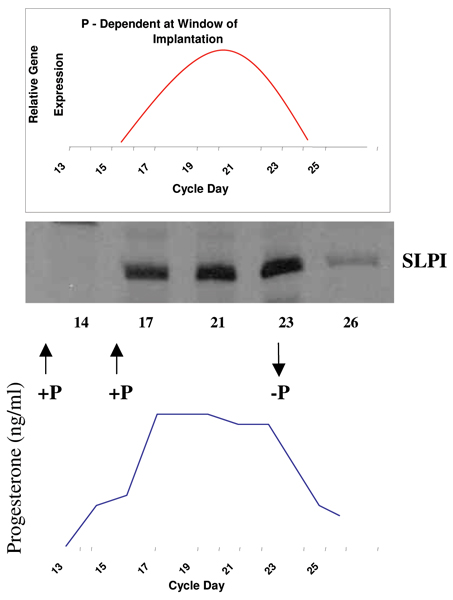
SLPI expression and hormonal levels of progesterone (P) during the expected window of receptivity in the rhesus monkey endometrium [56]. Upper panel shows the hypothetical expression pattern (red line) and the associated temporal pattern of SLPI expression as determined by PCR analyses. The lower panel shows the associated serum progesterone levels during this timeframe.